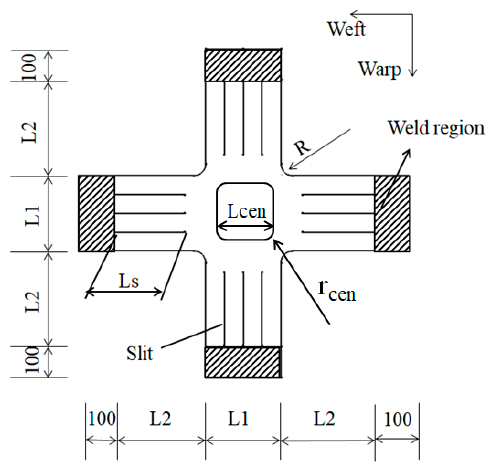
Figure 3. Geometry of modified cruciform specimen (Units: mm).